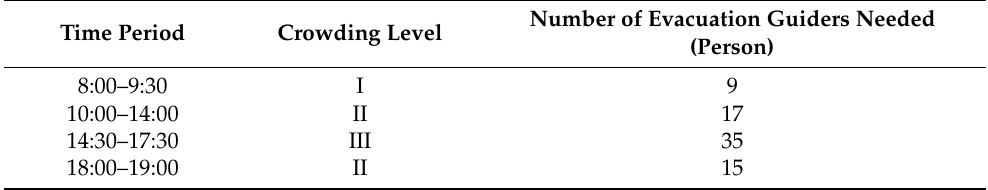
Table 4. Demand for evacuation guiders at different time periods in Binjiang Green